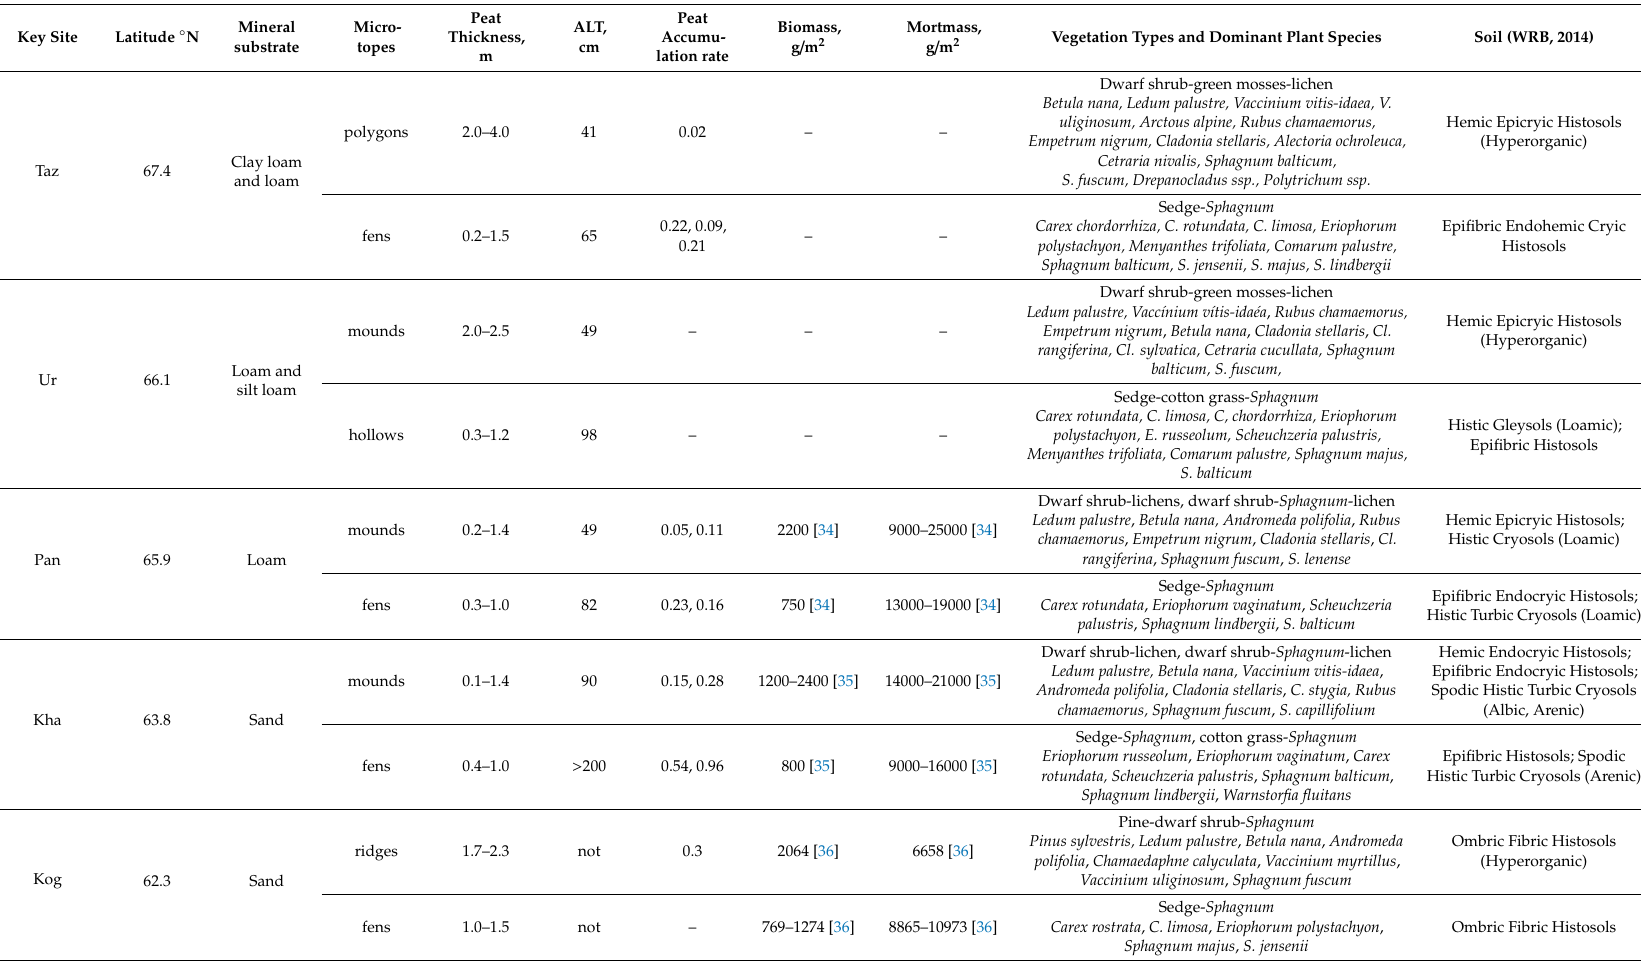
Table 1. Physico-geographical, permafrost, and ecosystem parameters of five key